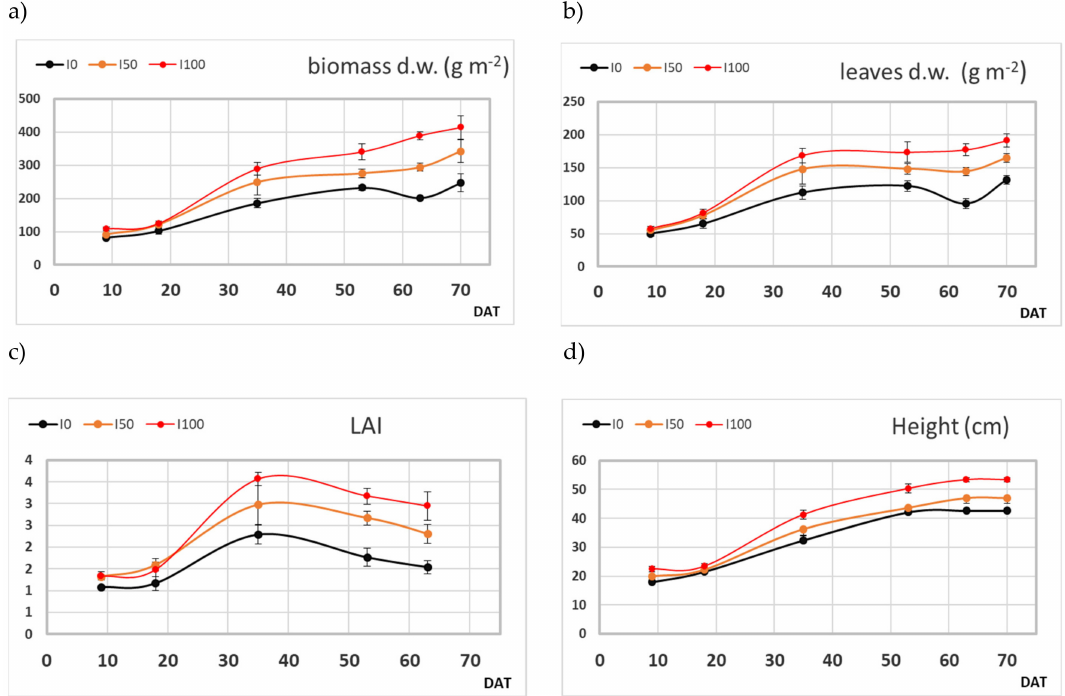
Figure 5. ( a ) Dry biomass (g plant − 1 ), ( b ) dry leaf (g plant − 1 ), ( c ) LAI, and ( d ) plant height (cm) of non-water-stressed (I 100 ), moderately water-stressed (I 50 ), and severely water-stressed (I 0 )